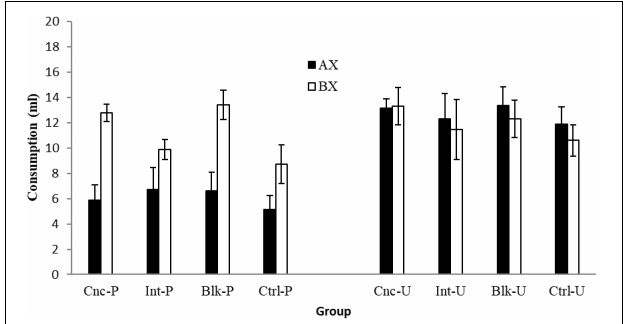
FIGURE 2 | Consumption (mean ± SEM) of the AX and BX solutions during the test trials for the 8 groups of Experiment